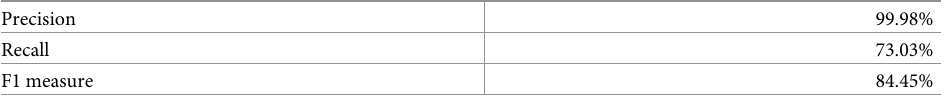
Table 1. Performance of the model for record linkage on the test